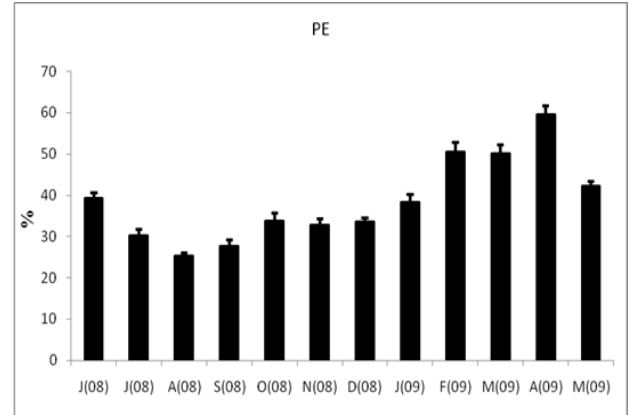
Figure 4: Seasonal variation of percentage edibility (%) in Mactra stultorum throughout the study period. Results are given as mean ± SD, n=30 replicates each month. Different letters indicate significant monthly difference for PE (HSD Tukey’s tests, p <